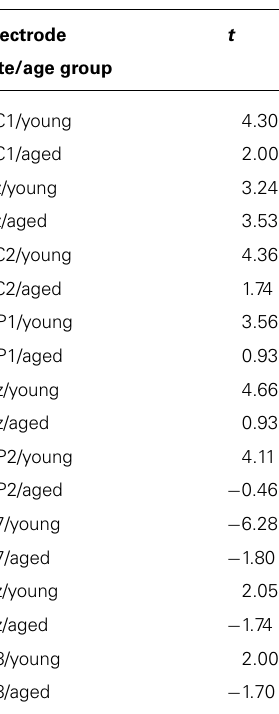
Table 2 | Latency range of 250–290